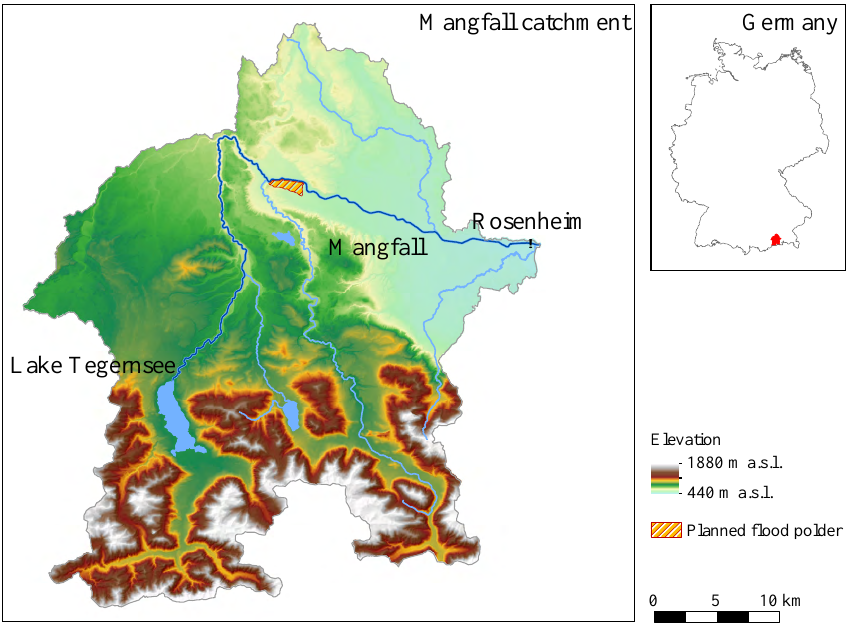
Figure 4. The Mangfall catchment and the case study site Rosenheim, Germany (Data source: Geobasisdaten © Bayerische Vermessungsver- waltung, www.geodaten.bayern.de, last access: 5 May 2018).